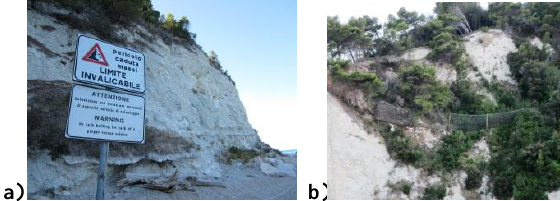
Figure 2. (a) Warning sign in a likely unstable area interested by rock fall, (b) an example of protective rock barrier fencing